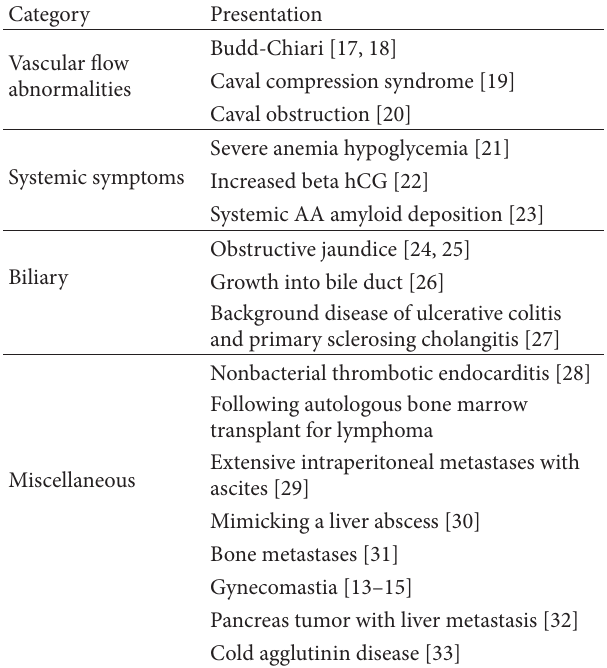
T 1: Unusual presentations for �brolamellar